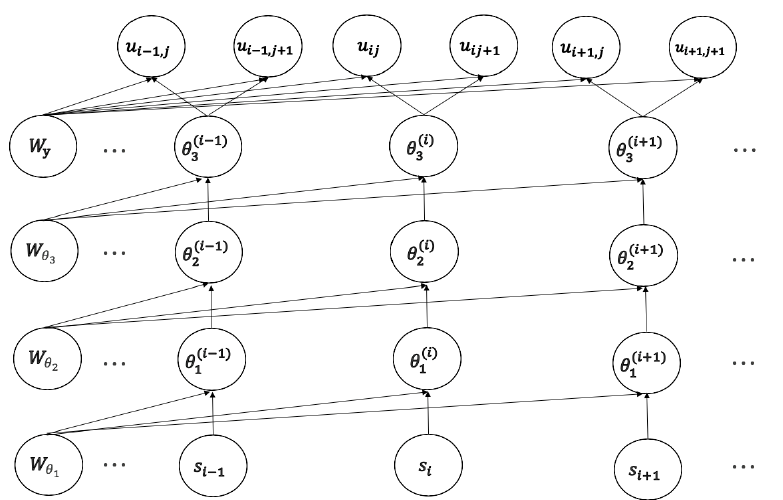
Figure 2. Examinee layer